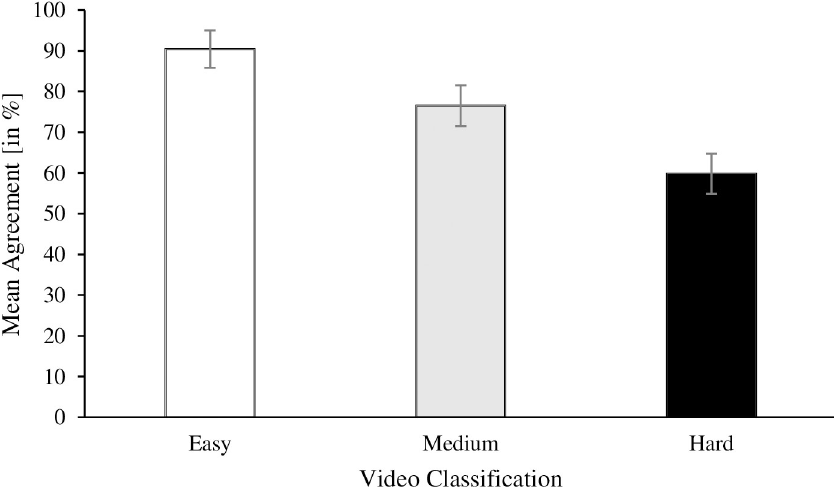
Fig 2. Mean agreement on easy, medium and hard videos. Note: Error bars resemble the 95% Confidence Intervals of the Mean.